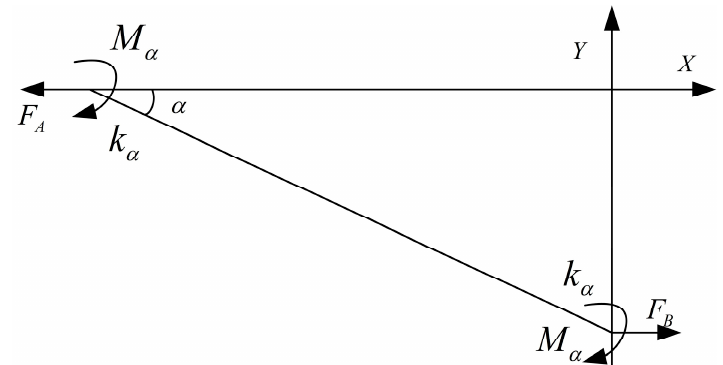
Figure 6. Force model of hourglass displacement amplification mechanism.